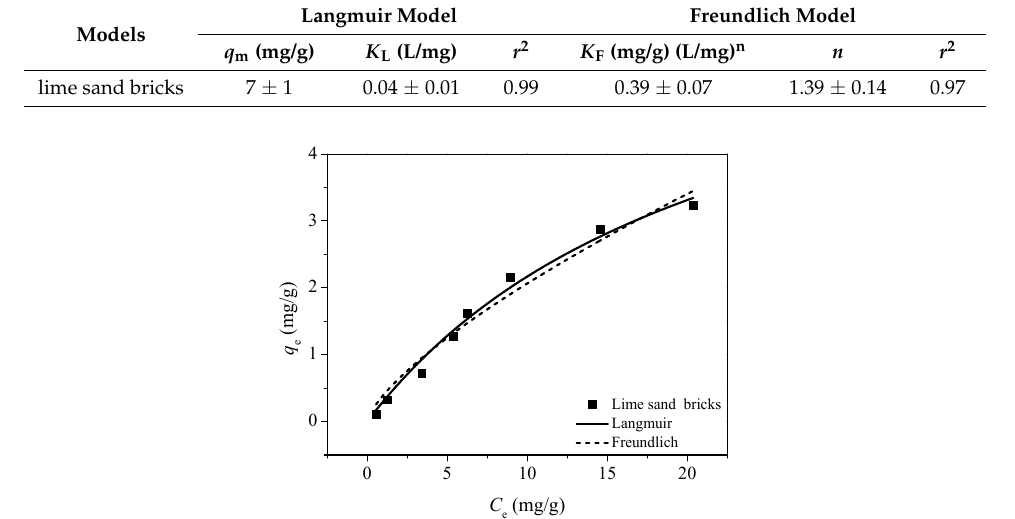
Figure 5. The adsorption isotherms of Cu(II) by lime sand bricks at 25 °C (solid-liquid ratio = 8 g/L, stirring speed = 135 rpm, pH = 5).